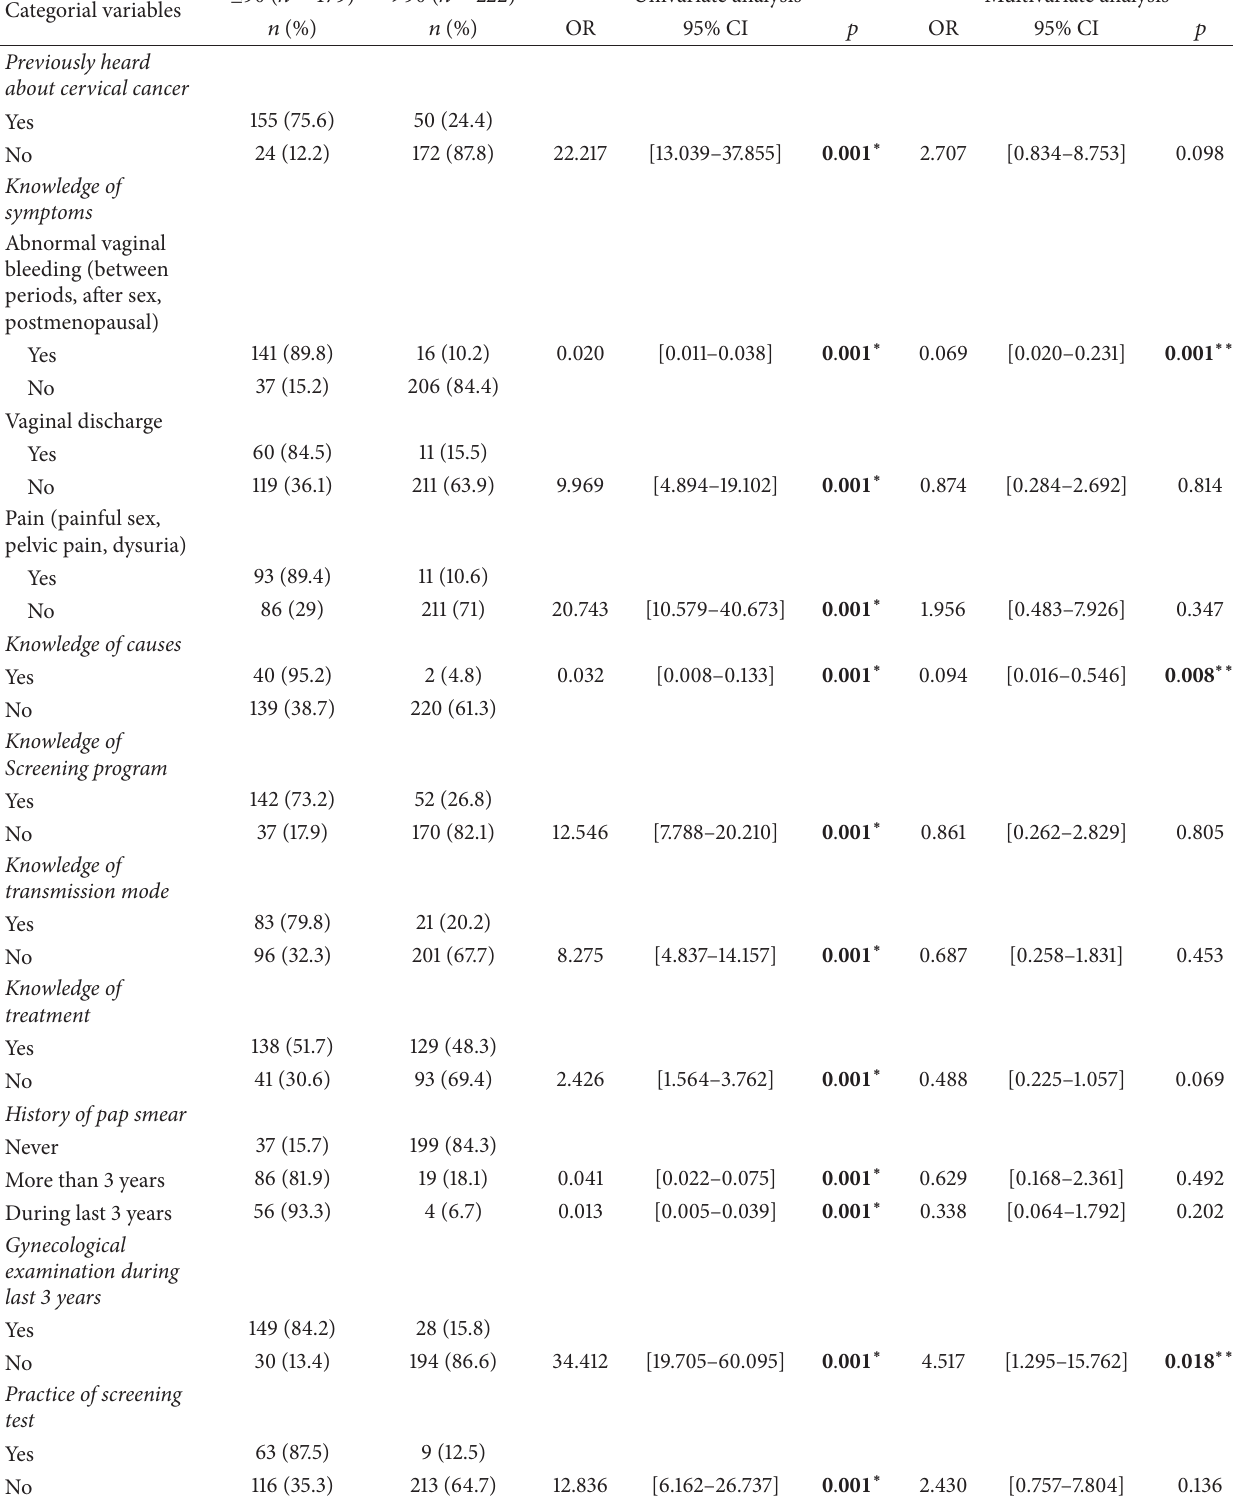
Table 5: Association between knowledge and practice and patient delay identified by multivariate